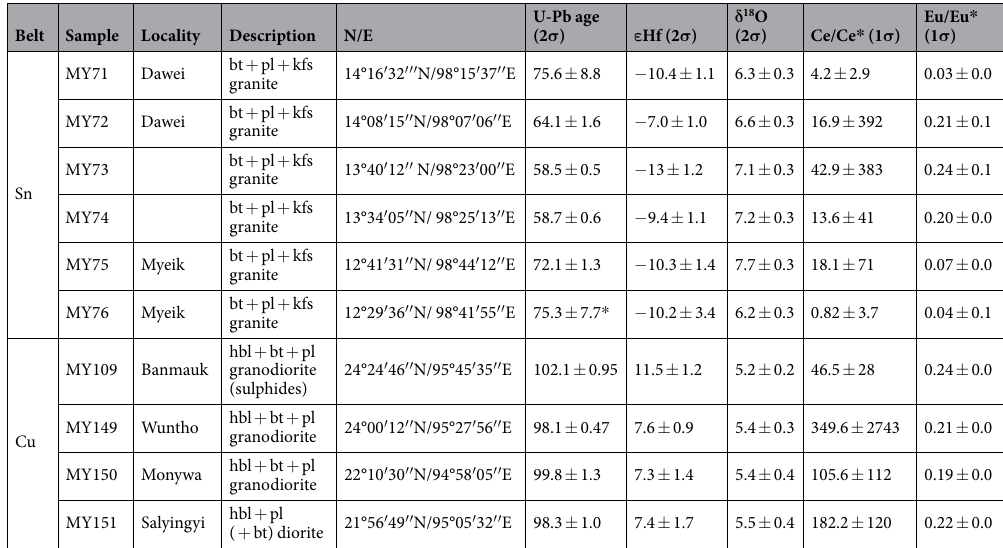
Table 1. Sample locations and a summary of key isotope and geochemical metrics as discussed in the text. * U-Pb age from Gardiner et al . (2016) 13